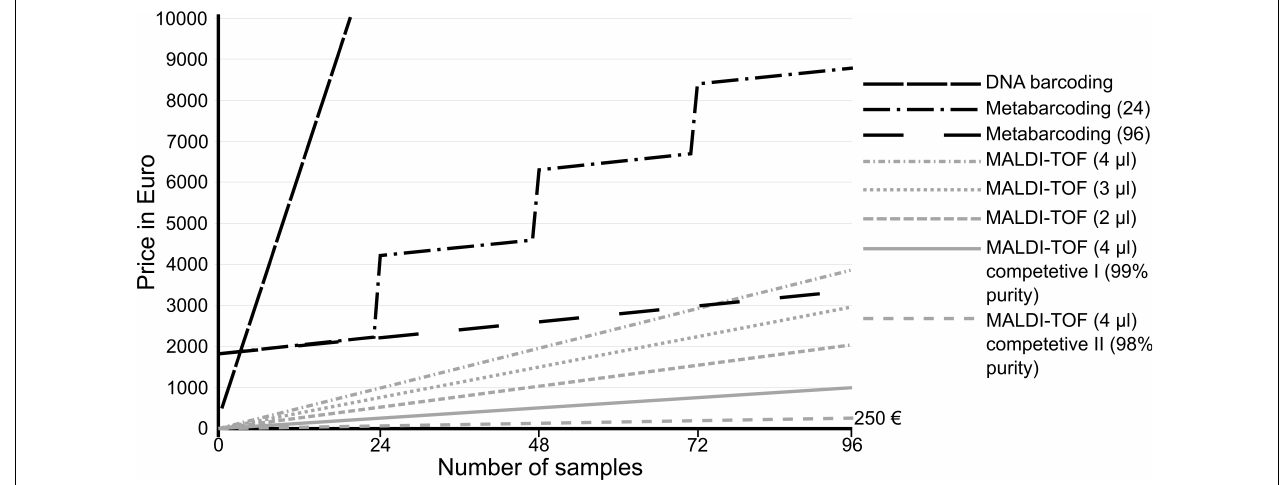
FIGURE 4 | Comparison of expenses of the different species identification methods for hypothetical samples containing 96 specimens each. Set-ups for 24 and 96 samples were compared for metabarcoding. Besides the factory-delivered matrix for MALDI-TOF MS, cheaper competitive products are available, allowing identification of 9,216 specimens for less than 250€. In actual studies, metabarcoding would analyze 100s and 1000s of specimens within a single sample and would outperform the other techniques in terms of costs. Here, hypothetical samples were used to allow